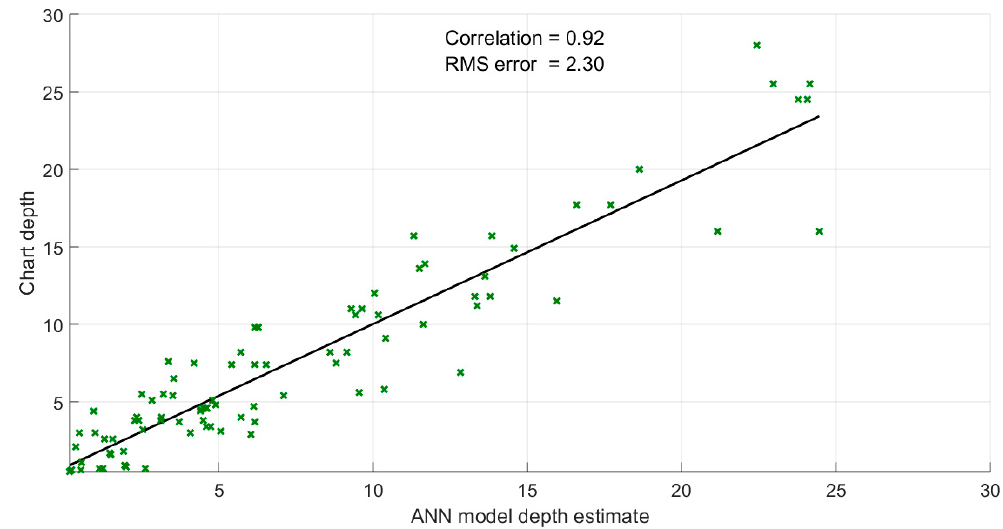
Figure 11. The correlation between modelled / validated depth estimates and “truth” nautical chart depths for the 90 collocated stations using the ANN model.